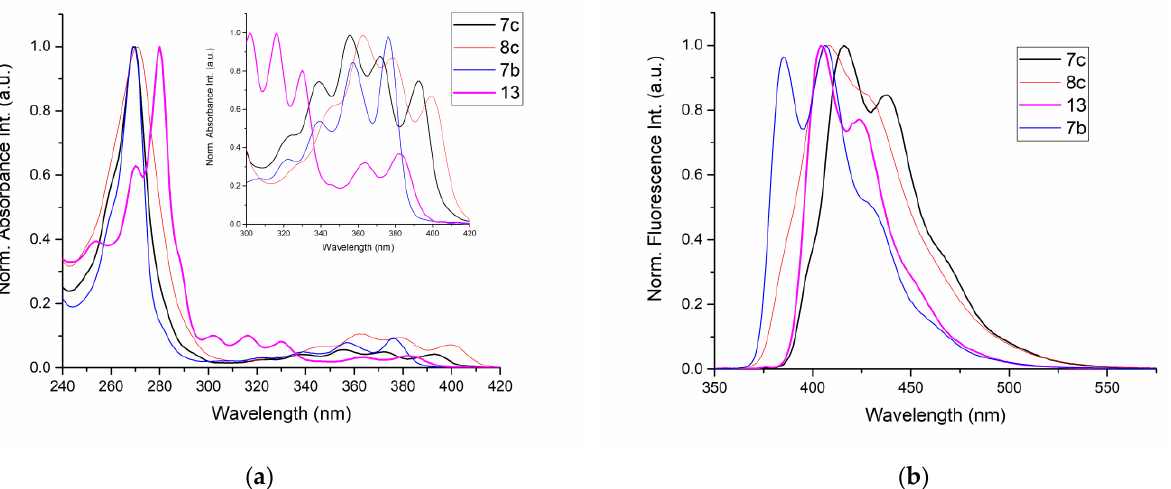
Figure 5. Normalized absorption ( a ) and emission ( b ) spectra of 7b , 7c , 8c and 13 in CH 2 Cl 2 (10 −5 mol/dm 3 , 25 °C). Table 2. Absorption and emission maxima (λ max ), Stokes shifts in dichloromethane solution (10 −5 mol/dm 3 , 25 °C) for 7b,c , 8c and 13 (underlined values are highest absorption maxima in the lower part of the spectrum in the 300 – 420 nm range).